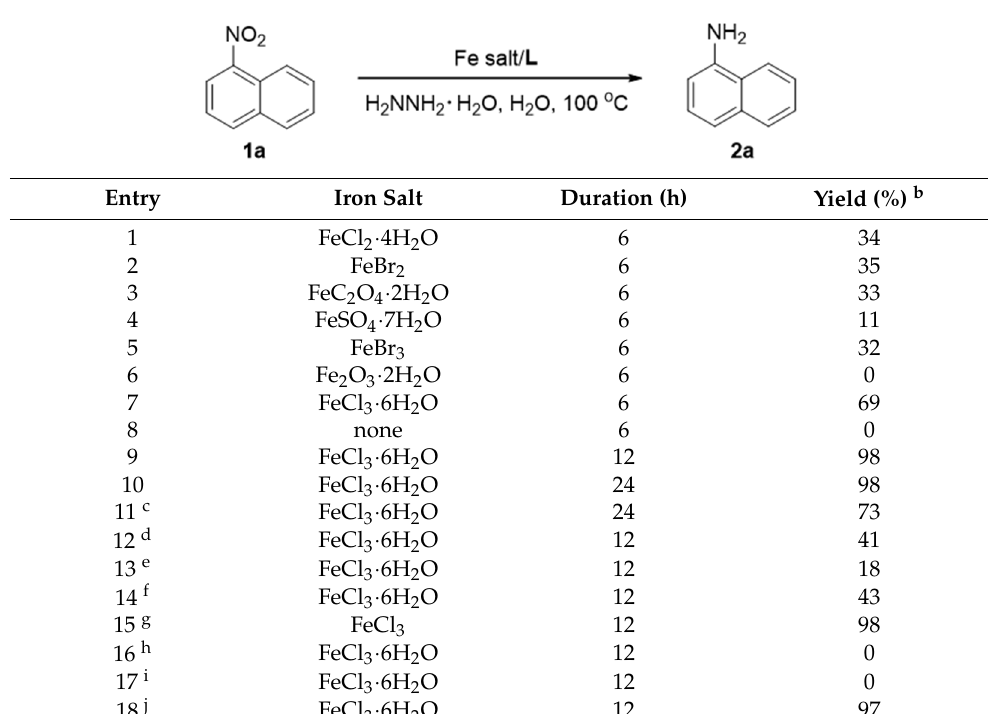
and HCOONH 4 , failed to reduce 1a and, hence, 1a remained intact (Entries 16 and 17). It